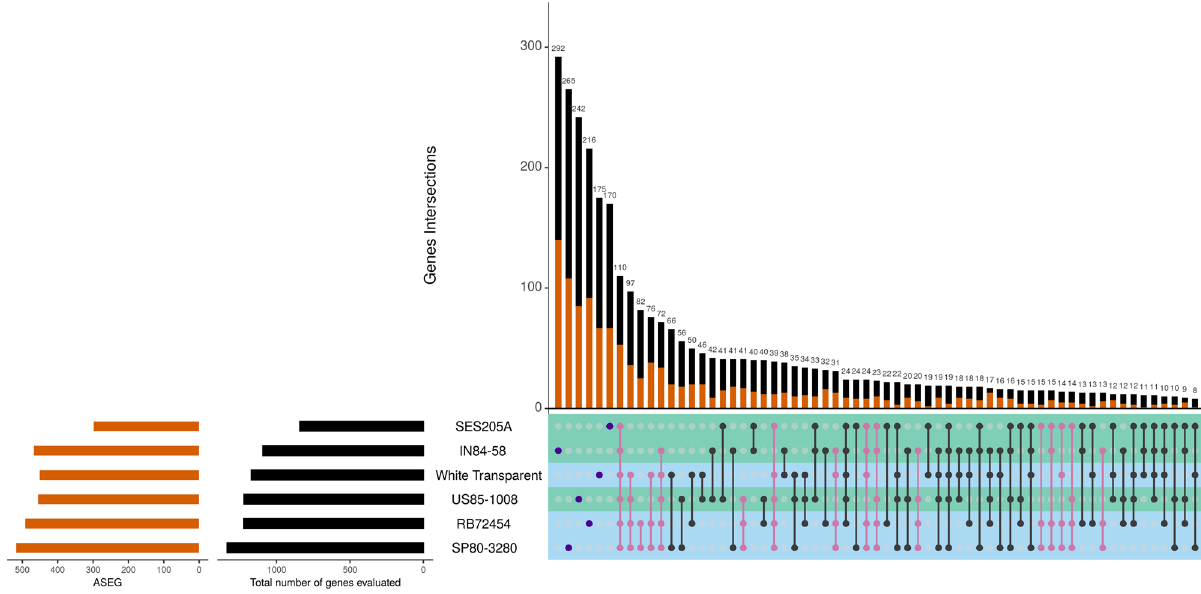
Figure 1. Intersections among the genes showing allele-specific expression (ASEGs) detected for each genotype. The number of ASEGs in each genotype is shown in orange and the total number of genes (ASEGs and non-ASEGs) is in black, on the left part of the plot. The right plot indicates all possible intersections among the genotypes, with ASEGs and non-ASEGs colored with the same scheme in the barplot. High fiber genotypes are shown with a green bar, and low fiber genotypes in blue. Purple dots indicate the exclusive genes of each genotype, pink dots represent the intersections where SP80-3280 and RB72454 are